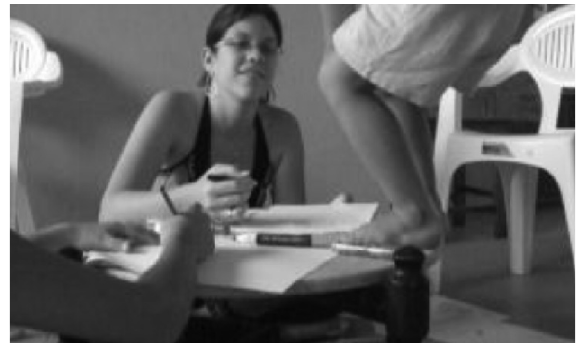
Figura 5. Criança sobe na mesa enquanto fala sobre a escada.